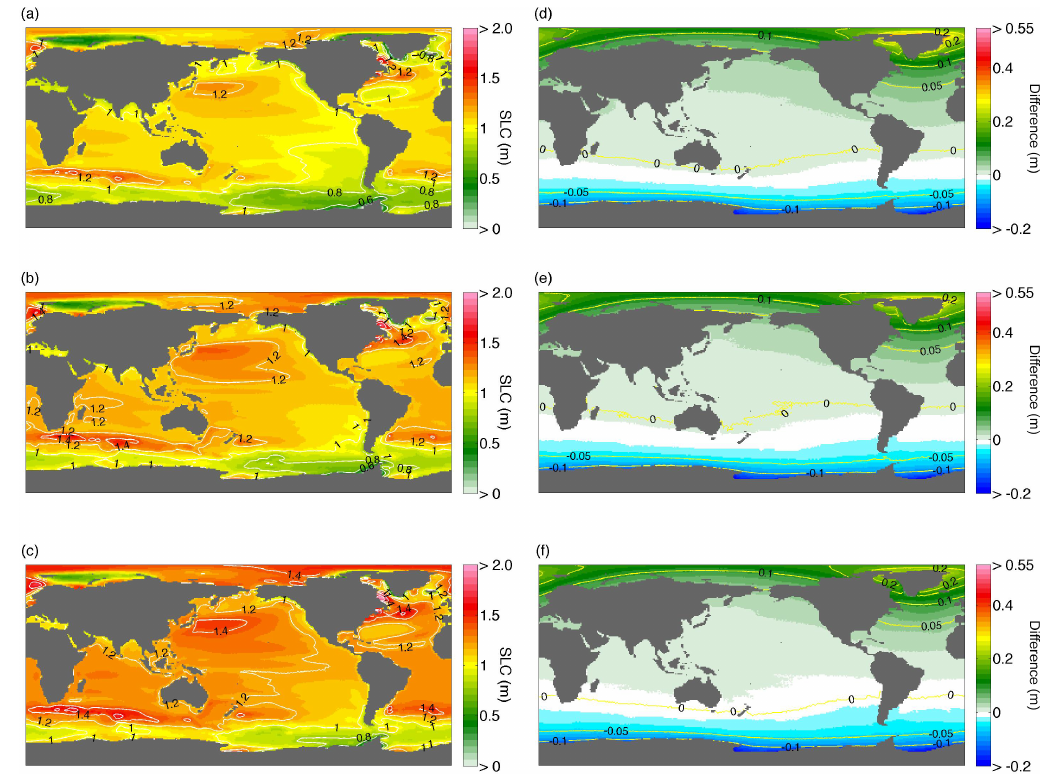
Figure 8. Left column: (a) 90th, (b) 95th and (c) 97.5th percentile for the asymmetric Ritz distribution of dynamical ice sheet mass loss of East and West Antarctica ice sheets (EAIS and WAIS) combined with symmetric IPCC-based contributions of dynamical ice mass loss of the Greenland ice sheet (GIS) and regional sea level change projections following RCP8.5 (Slangen et al., 2014). Right column: difference between (d) 90th, (e) 95th and (f) 97.5th percentile for asymmetric Ritz and symmetric IPCC-based ice dynamical contribution of EAIS and WAIS, both combined with symmetric IPCC-based contributions of dynamical ice mass loss of the Greenland ice sheet (GIS) and regional SLC projections following RCP8.5 (Slangen et al., 2014). Percentiles for the symmetric IPCC-AR5 probability distribution are depicted